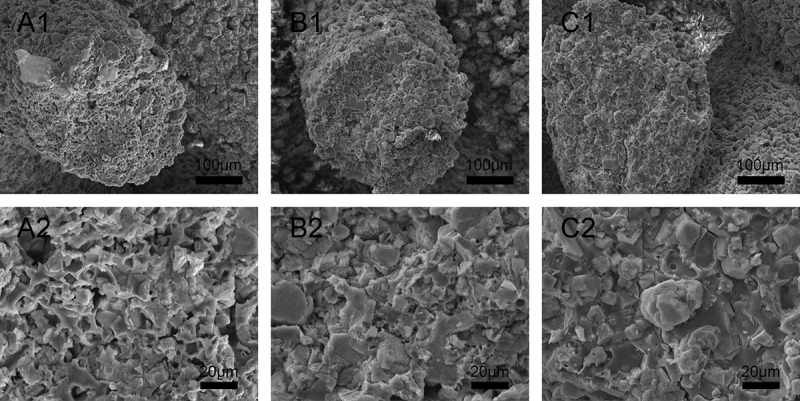
SEM images of fracture surface of β-Ca2SiO4 scaffolds sintered at 1000 °C (A1–A2), 1100 °C (B1–B2), and 1200 °C (C1–C2).